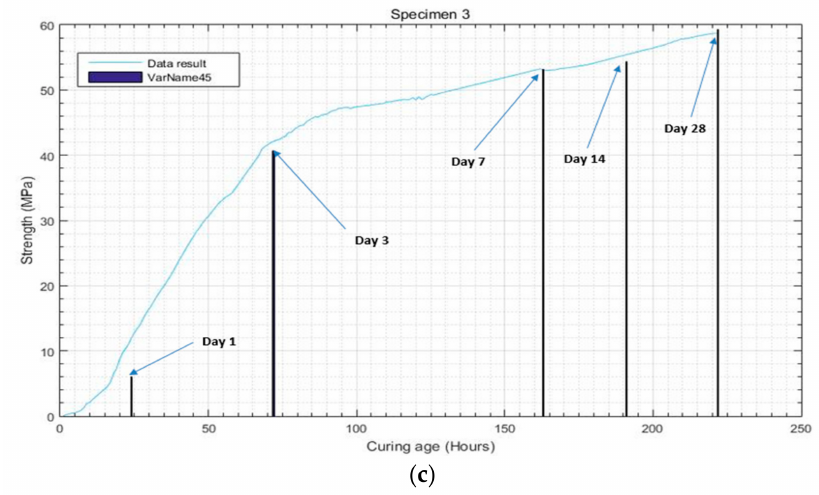
Figure 9. ( a – c ) show the comparison between the actual compressive strengths of concrete and the predicted strengths of